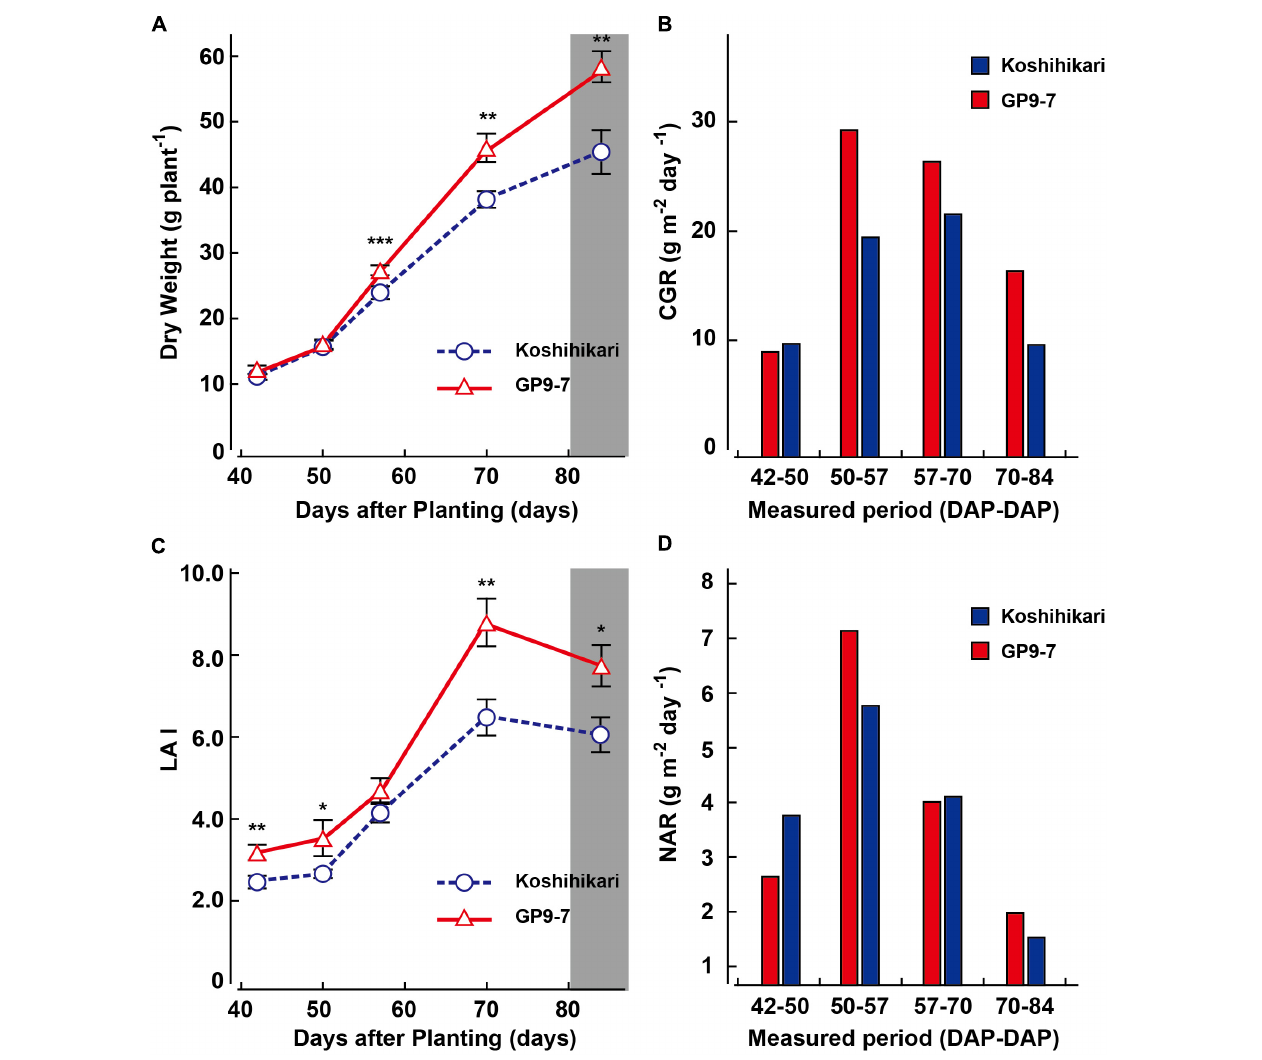
FIGURE 3 | Developmental transitions of growth traits of Koshihikari (blue circles with broken lines or blue bars) and GP9-7 (red triangles with solid lines or red bars) from the vegetative to the reproductive growth phase. Transitions of dry weight per plant (A) , crop growth rate (CGR) (B) , leaf area index (LAI) (C) , and net assimilation rate (NAR) (D) of Koshihikari and GP9-7 grown in a test field at Tsukuba, Japan in the summer of 2018 (planting date: May 9, 2018). Mean values of the dry weights and leaf area indexes obtained from seven plants are plotted. The SE values are shown as error bars in the graphs. The period for heading is indicated by a vertical gray bar. Symbols, ***, **, and * indicate statistically significant differences compared to Koshihikari at P < 0.001, P < 0.01, and P < 0.05, respectively, calculated by the Welch’s t -test.